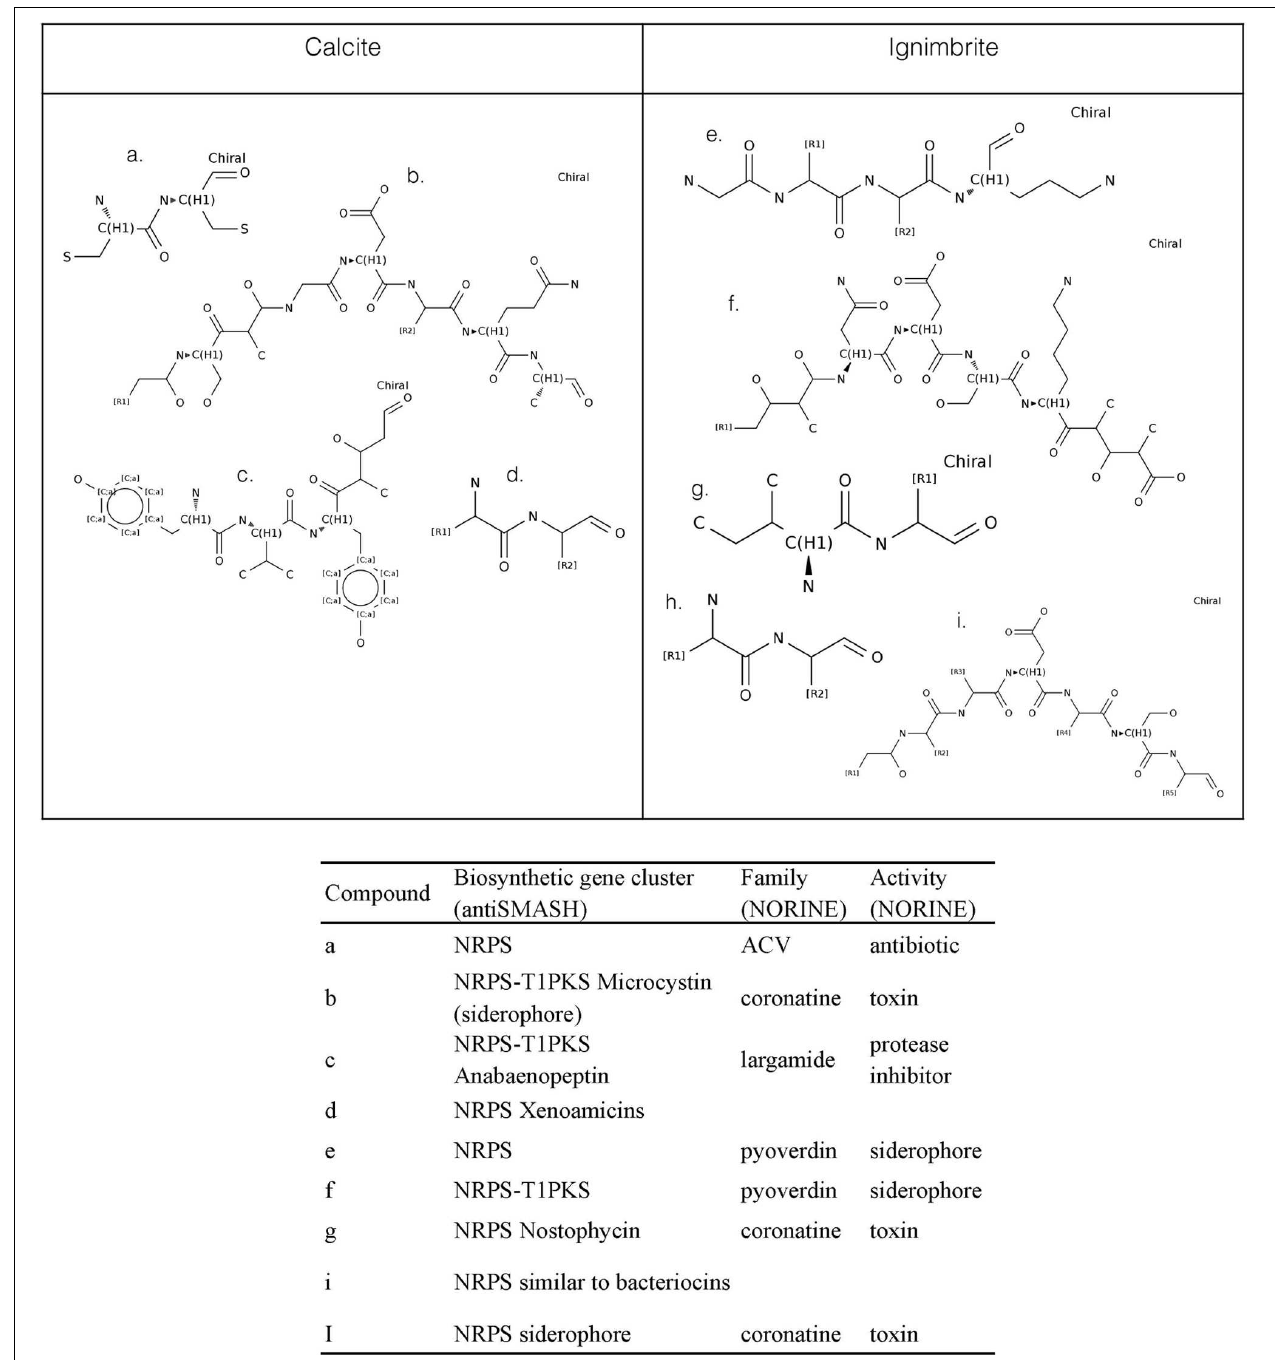
FIGURE 6 | NORINE predictions for putative products of NRPs synthetases and PK synthases gene clusters found in the draft genomes of cyanobacteria from the calcite (Ca9) and ignimbrite (Ig12) communities.